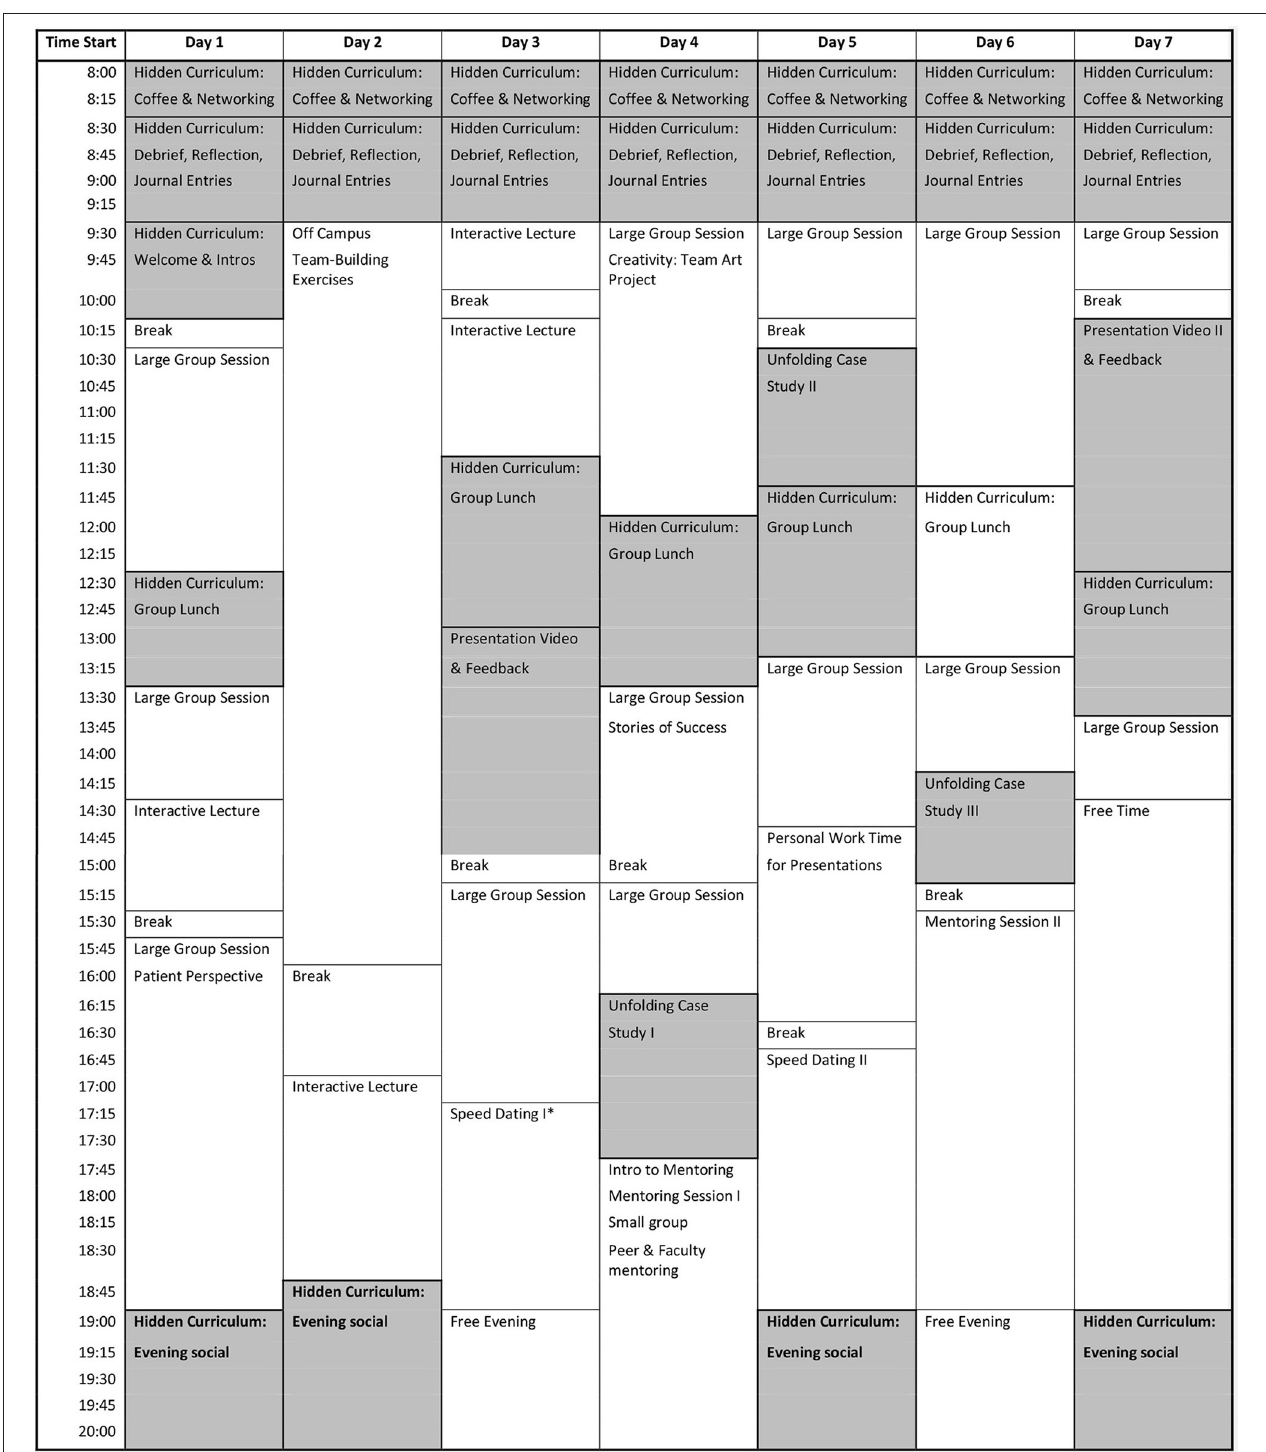
FIGURE 1 | Sample curriculum design for translational medicine. Shaded area indicates strategies that are highlighted in this publication. *Participants have the opportunity to voluntarily sign up and meet individually with a faculty member for 10min.